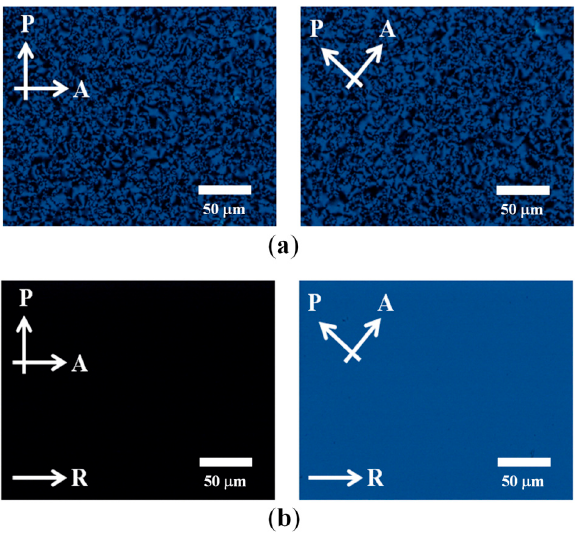
Figure 4. Polarizing optical microscopic images of guest-host films. ( a ) On a non-rubbed alignment layer; and ( b ) on a rubbed alignment layer. The arrows indicate the transmission axes of the polarizer (P) and analyzer (A), and the rubbing (R) direction of the alignment layer.